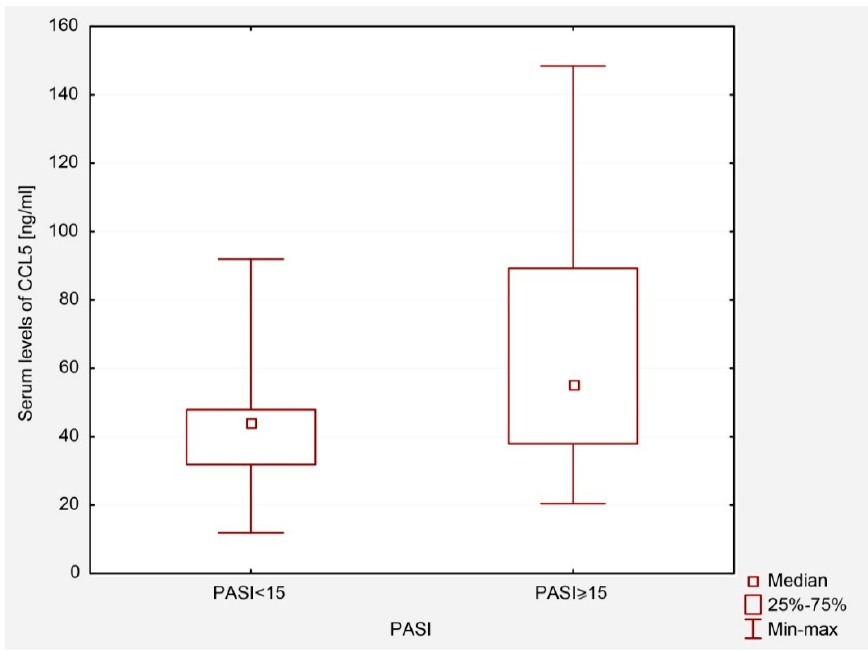
Figure 1. Serum levels of CCL5/RANTES in patients with PASI < 15 and PASI ≥